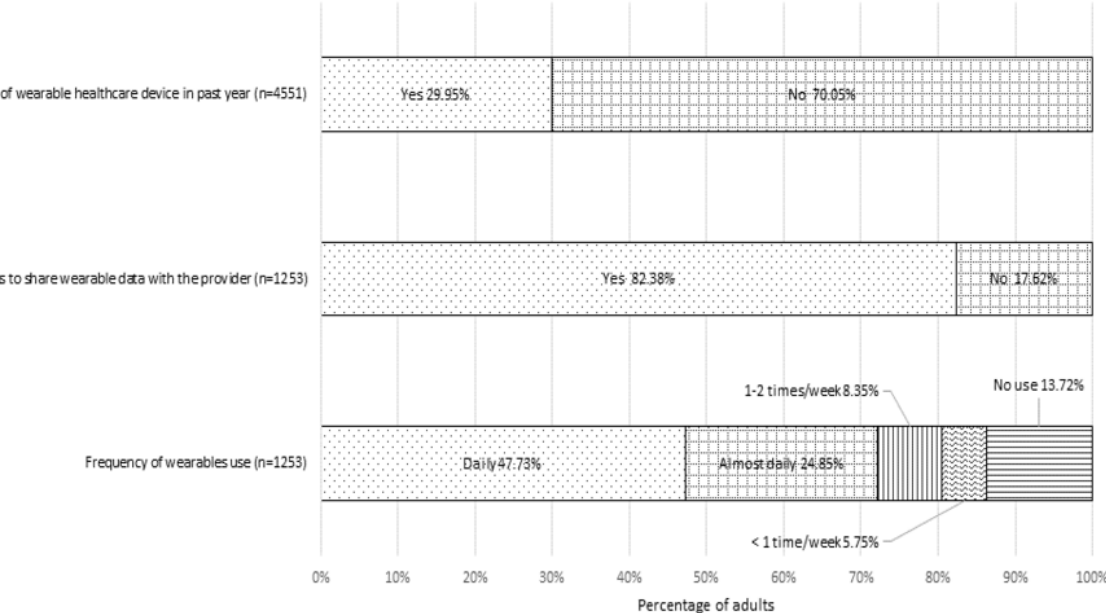
Figure 2. Patterns of wearable health device use by US